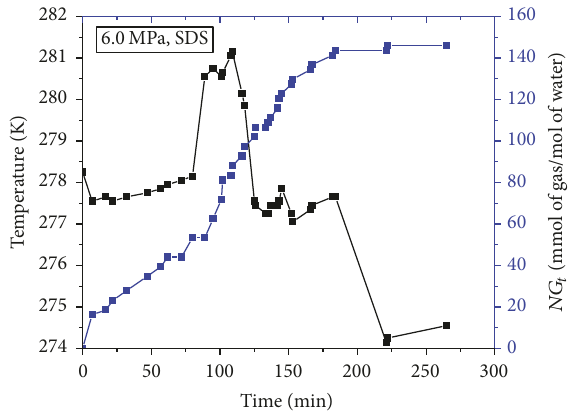
Figure 2: Hydrate formation in 300 ppm SDS solution at 6.0